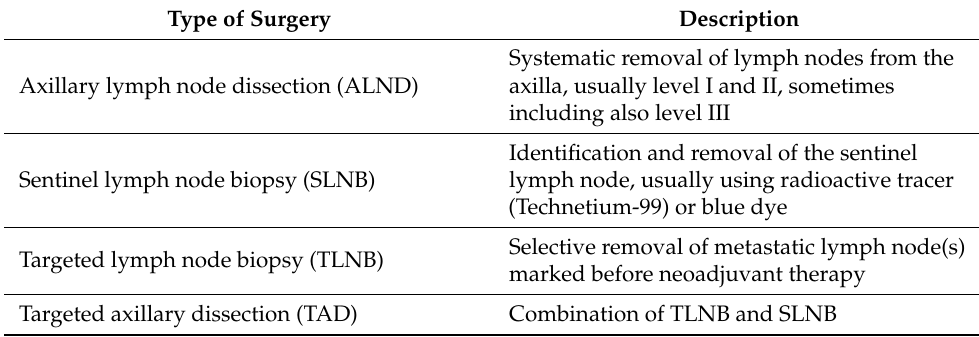
Table 1. Axillary surgical staging techniques: The most important